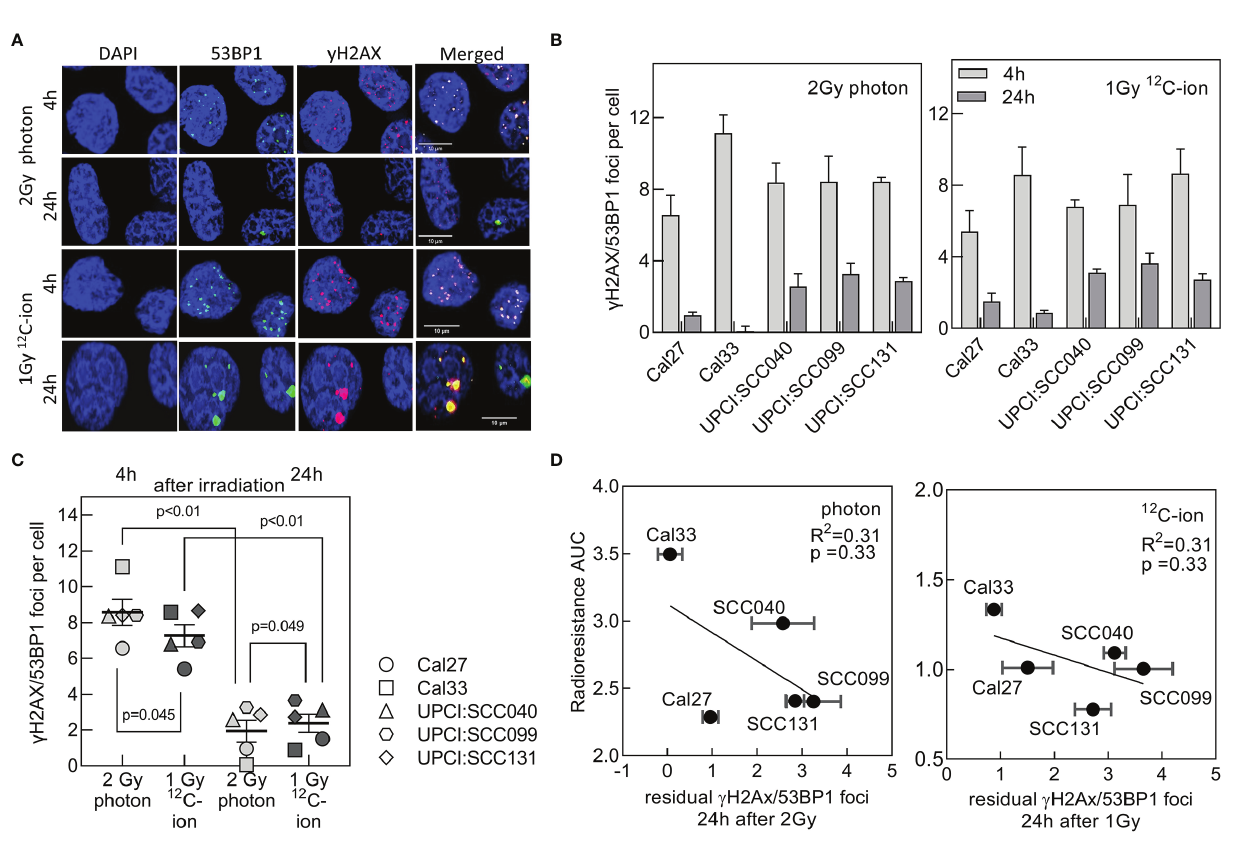
FIGURE 2 | DSB repair ef fi ciency after photon and 12 C-ion irradiation. Cells were exposed to 2 Gy photons or 1 Gy 12 C-ions and after repair incubation for 4 and 24 h DSBs were detected via g H2AX/53BP1 co-localization. (A) Representative pictures for immuno fl uorescence co-staining of foci with 53BP1 (green), g H2AX (red), and counterstaining of the nucleus with DAPI (blue). Cell line: Cal33. (B) Number of co-localizing foci 4 and 24 h after irradiation after background subtraction (foci at 0 Gy). (C) Comparison of repair ef fi ciencies between photon and 12 C-ion irradiation. Values are presented as MV +/- SEM after background subtraction (foci measured in unirradiated samples). p values were calculated using t-test statistics. p < 0.05 are considered signi fi cant. (D) Correlation of radioresistance AUC with residual g H2AX/53BP1 foci for photon and 12 C-ion